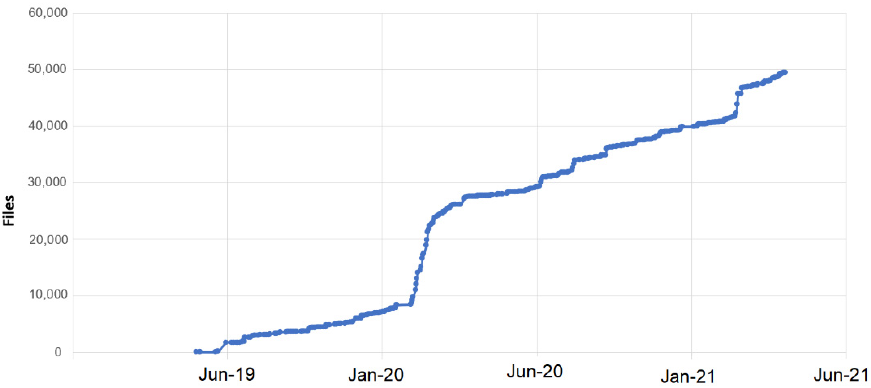
Figure 13. Detail of nomenclature assignment of different parts of the model. Definition of the no ‐ menclature of the forward pass “PE” and the destroy pass “PD”.